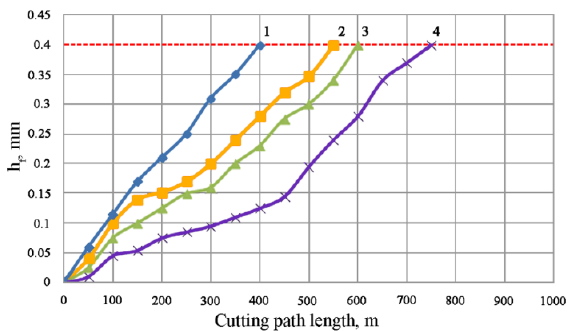
Figure 16. Comparison of wear on the flank surface for textured and original tools at V = 25 m/min, S = 0.1 mm/rpm, t = 0.5 mm: 1 — initial, 2 — initial textured, 3 — with coating, 4 — coated and textured.